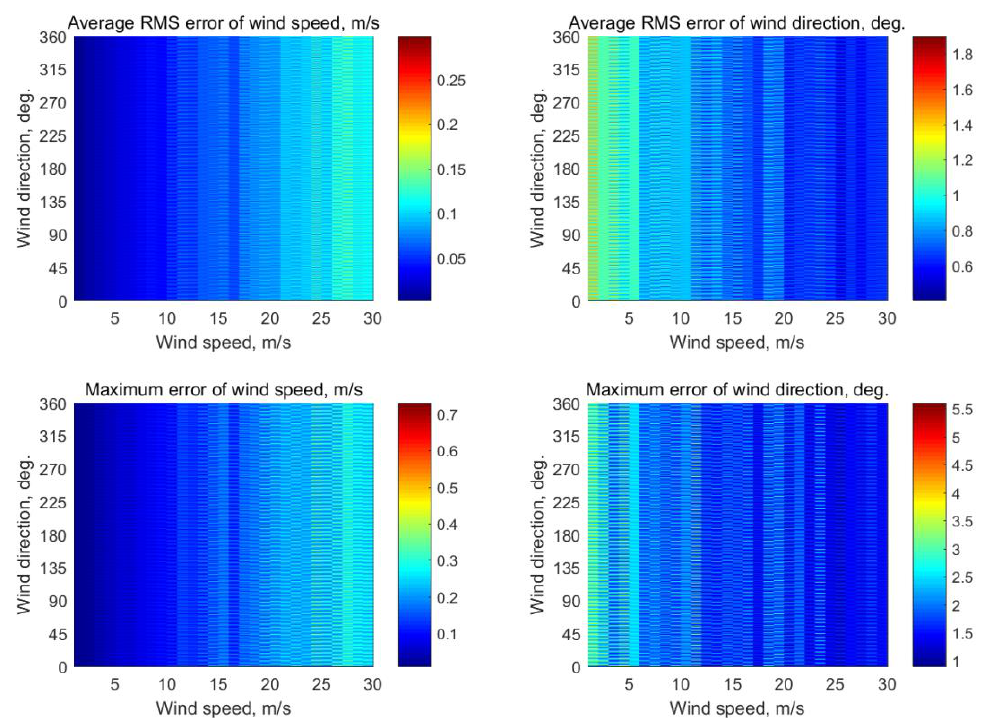
Figure A21. Simulation results of the use of four incidence angles of 40°, 45°, 50°, and 55° for wind retrieval.